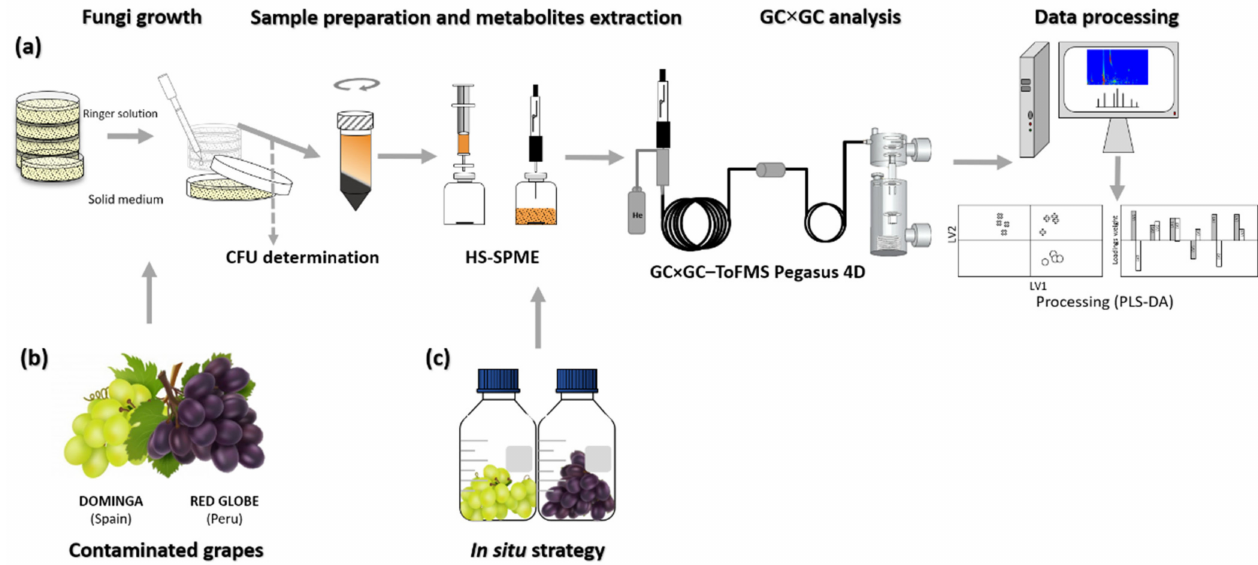
Figure 1. Workflow established for the three strategies used in this study: ( a ) evaluation of the volatile exometabolome for 1 day of growth of A. niger cultures, based on [14] ( b ) analysis of A. niger cultures obtained from previously contaminated grapes and ( c ) direct analysis of contaminated table grapes with A. niger (in situ